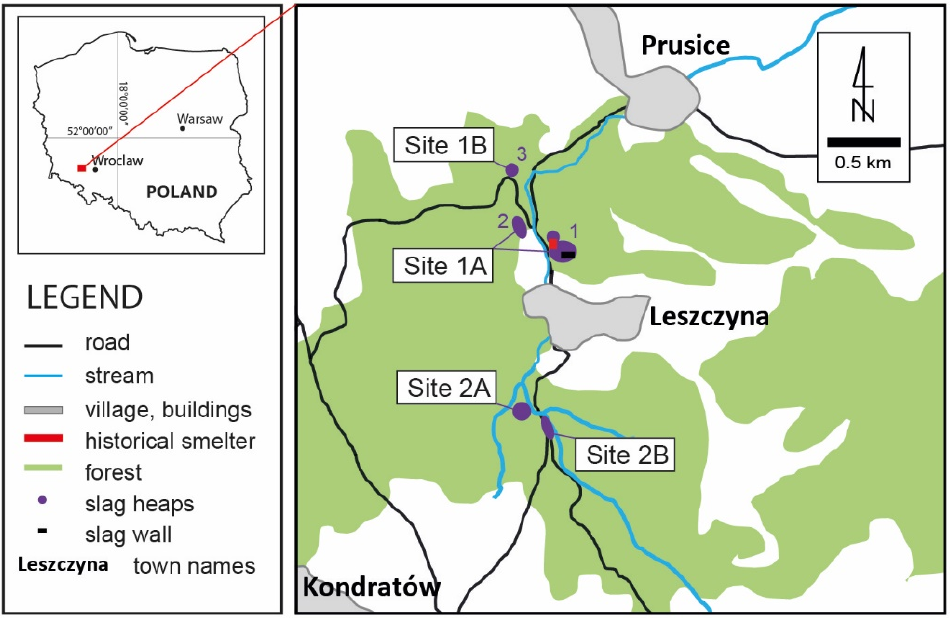
Figure 1. Research site location in Poland and the Leszczyna vicinity. Purple numbers (1, 2, 3) are mentioned in the text to distinguish different parts of the sites.